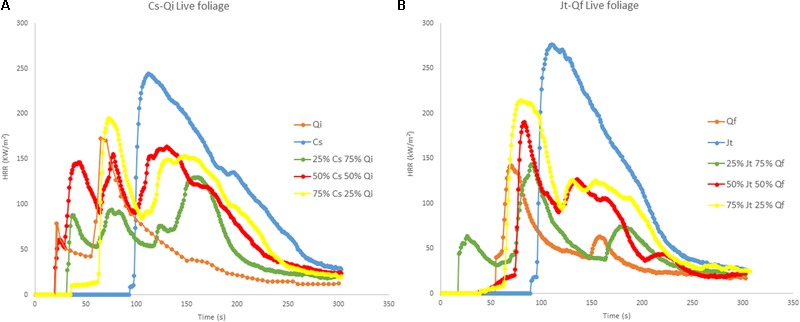
Heat Release Rate (HRR) curves (MLC tests at 50 kW/m2) of live foliage: (A) pure samples of C. sempervirens (Cs) and Q. ilex (Qi), and mixtures of Cs-Qi; (B) pure samples of J. thurifera (Jt) and Q. faginea (Qf) and mixtures of Jt-Qf. The tests for the mixtures were carried out for three different proportions of the two mixed species (25/75; 50/50; 75/25).